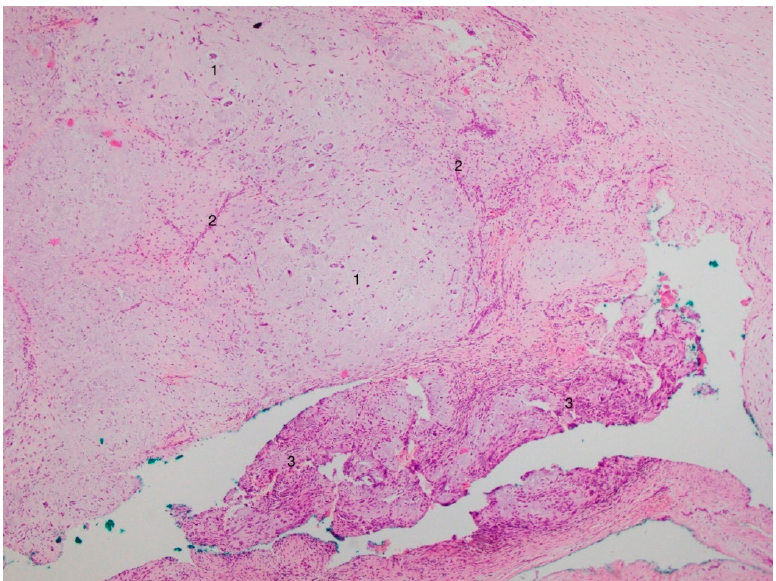
Figure 4. Postoperative material. H+E staining. A high ‐ grade solid component resembling undifferentiated pleomorphic sarcoma is seen [3] (bottom), juxtaposed to a myxoid matrix [1] area exhibiting typical features of myxofibrosarcoma (moderate cellularity, mild atypia, prominent elongated vessels [2]). Appl. Sci. 2021 , 11 , x FOR PEER REVIEW